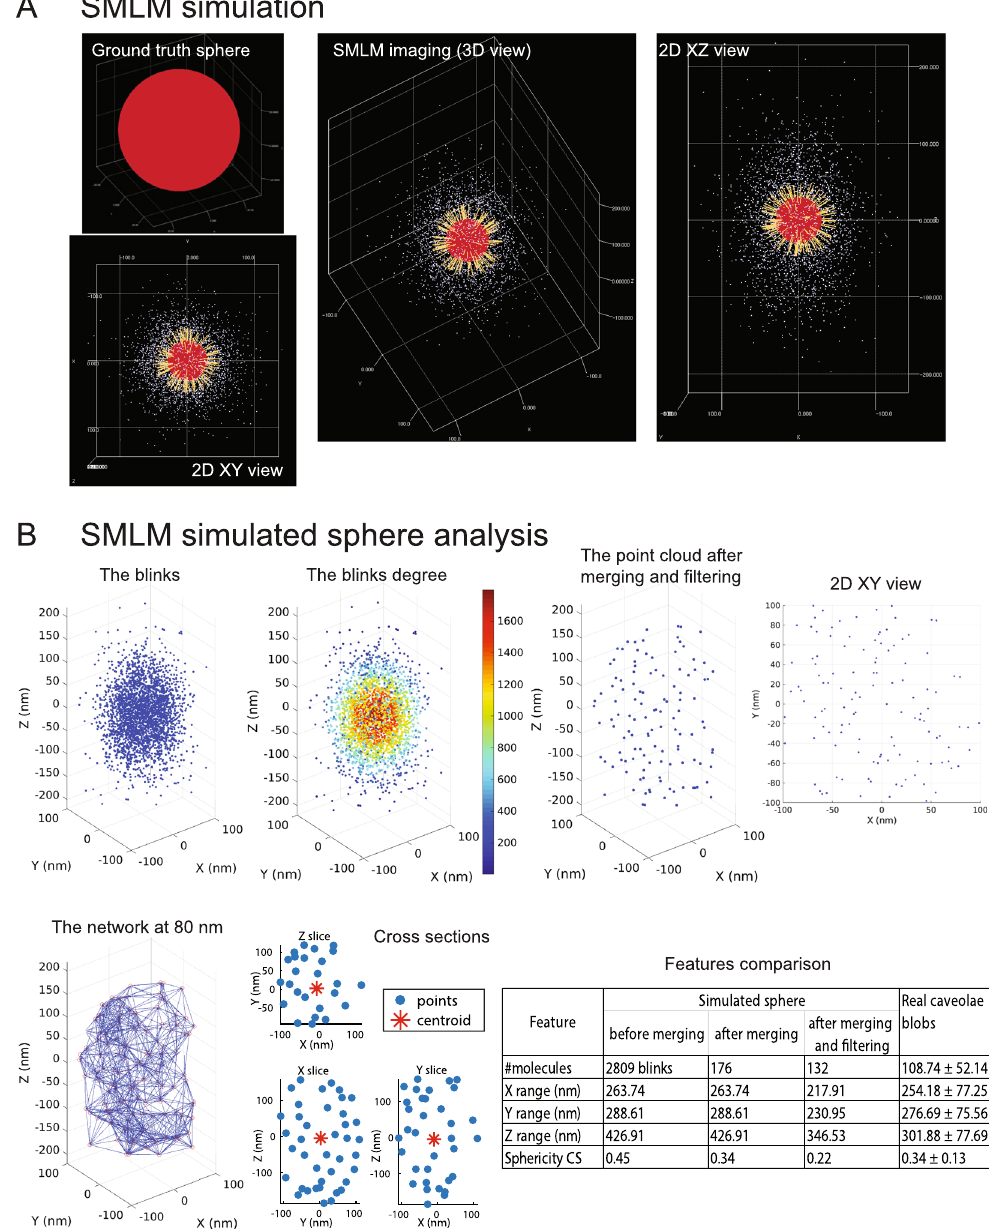
Figure 8. Network analysis of a simulated 60 nm sphere using SuReSim software. ( A ) A ground truth sphere that mimics caveolae-like structures with 60 nm diameter appears in red was used to obtain an SMLM event list using SureSim software using labeling and acquisition parameters experimentally derived from single antibody blinking data (Fig. 7). The yellow bars represent the epitopes and the white points the acquired blinks. In the SuReSim software simulation, we set the lateral precision (XY) to be 20 nm and the axial precision (Z) to be 38 nm and the epitope density to be 0.012821 nm − 2 with labeling efficiency of 100% to match the reported 145 Cav1 molecules per caveolae 57 . 3D and 2D views of the imaged point clouds show increased Z spread, reflecting the poorer Z resolution relative to XY resolution. ( B ) Analysis of biological signatures of the simulated SMLM data of a 60 nm sphere relative to the real SMLM-imaged caveolae. We analyzed the simulated data using the same pipeline (Fig. 1C) used to analyze the real data. We calculated the network degree for the blinks before merging then preprocessed the data by merging the blinks at 20 nm and, then, filtered out the noisy blinks. The resultant point clouds are shown in 3D and 2D views. The dimensions of the point clouds are similar to the bio- signatures of the caveolae blobs that we obtained for real data (Fig. 5A–D and Fig.